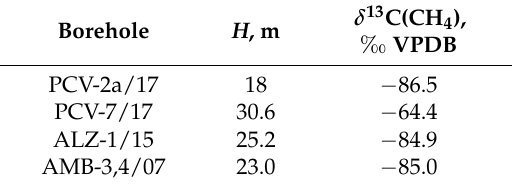
Table 3. Isotopic signature of methane in the